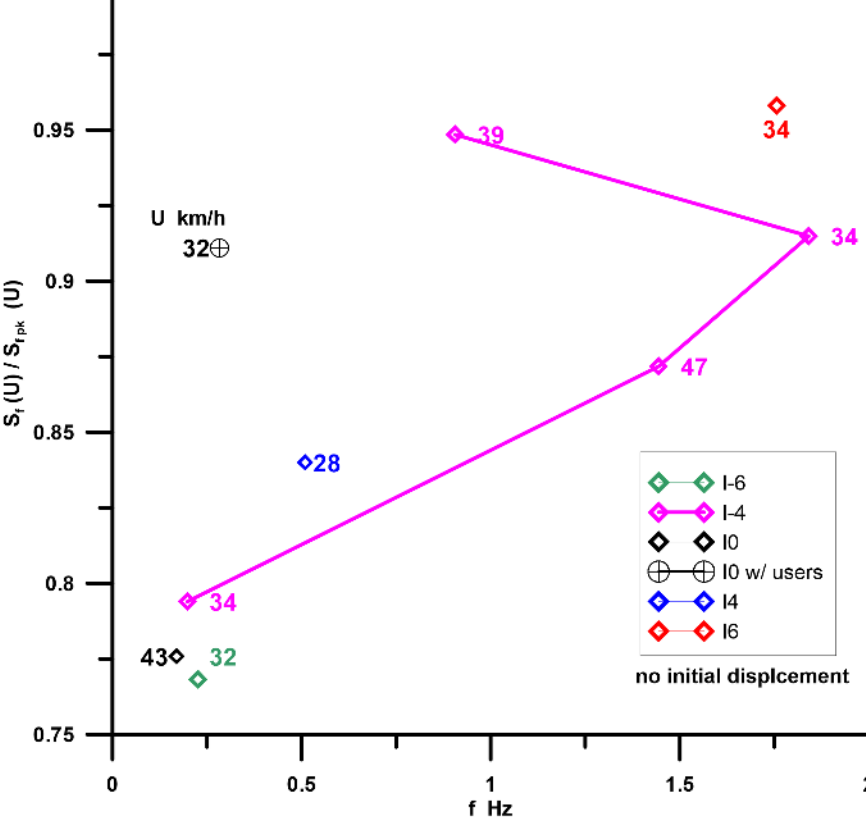
Figure 17. Ratios of significant Sf values — Sf > 0.75 Sf pk — to (Sf) pk . The spectral peak component corresponds to a frequency that is always close to